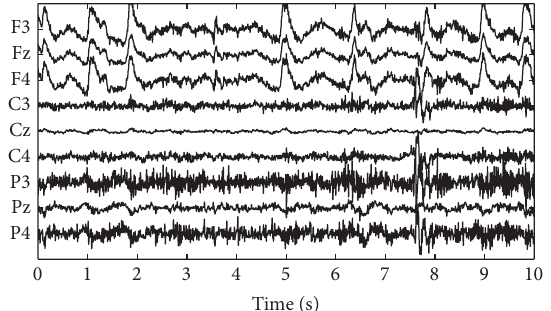
Figure 2: The original 10-second scalp EEG recordings during cycling.